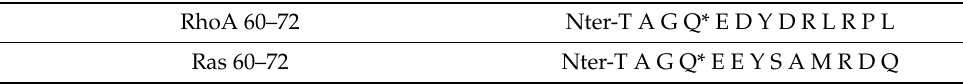
Table 2. Sequences of peptides docked on CNF1 conformations using FlexPepDock [20]. The Q63 residues undergoing deamidation are labeled with an asterisk